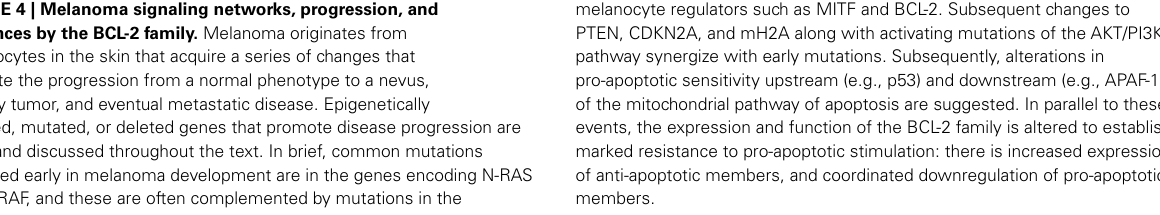
melanocyte regulators such as MITF and BCL-2. Subsequent changes to PTEN, CDKN2A, and mH2A along with activating mutations of the AKT/PI3K pathway synergize with early mutations. Subsequently, alterations in pro-apoptotic sensitivity upstream (e.g., p53) and downstream (e.g., APAF-1) of the mitochondrial pathway of apoptosis are suggested. In parallel to these events, the expression and function of the BCL-2 family is altered to establish marked resistance to pro-apoptotic stimulation: there is increased expression of anti-apoptotic members, and coordinated downregulation of pro-apoptotic